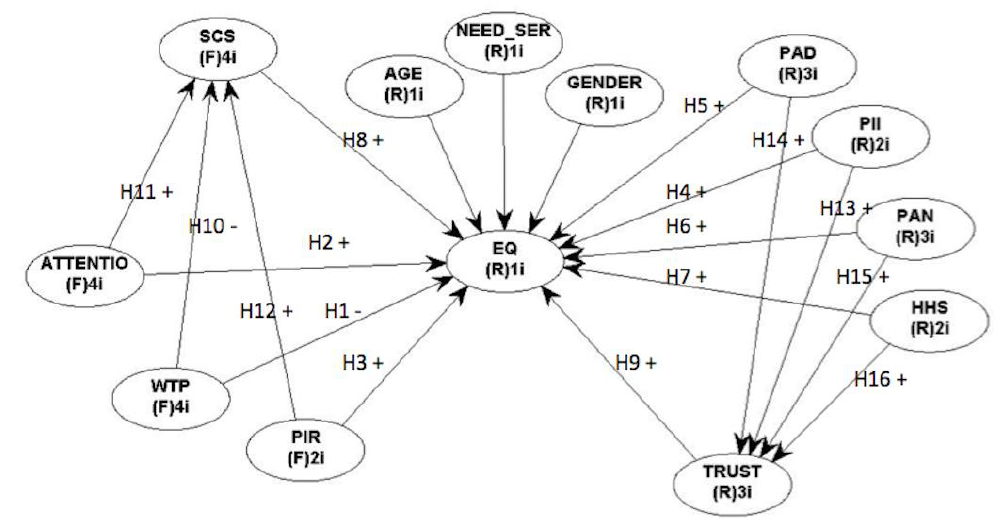
Figure 1. Conceptual research model and hypotheses.